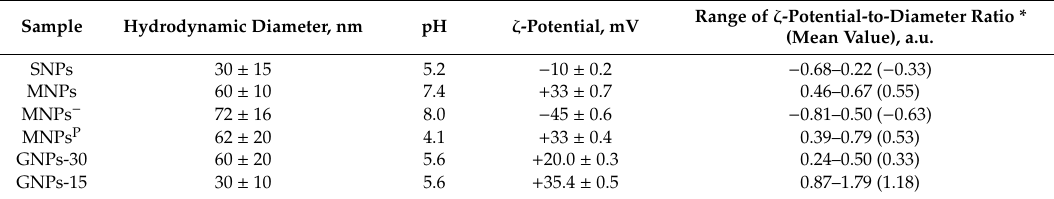
Table 1. Hydrodynamic size, ζ -potential of NPs, and their